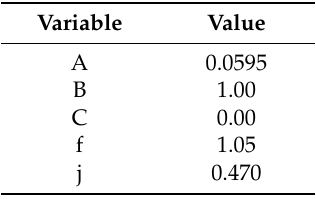
Table 4. Results of the parameters adjusted by the least squares method.